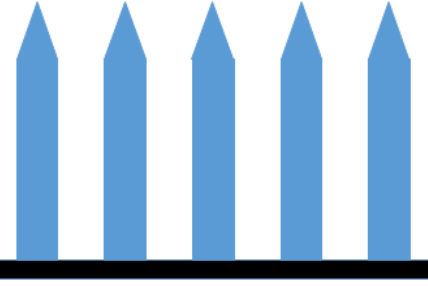
Figure 13. Cross-sectional design of the microneedle array [167]. Lim et al. used 3D printing for manufacturing a dual-function microneedle array on personalized curved surfaces (microneedle splint) for drug delivery and splinting of the affected finger. Sufficient penetration efficiency was achieved, and the final microneedle splint showed biocompatibility. A significantly higher amount of diclofenac permeated through the skin with the use of the microneedle splint as compared to intact skin. The